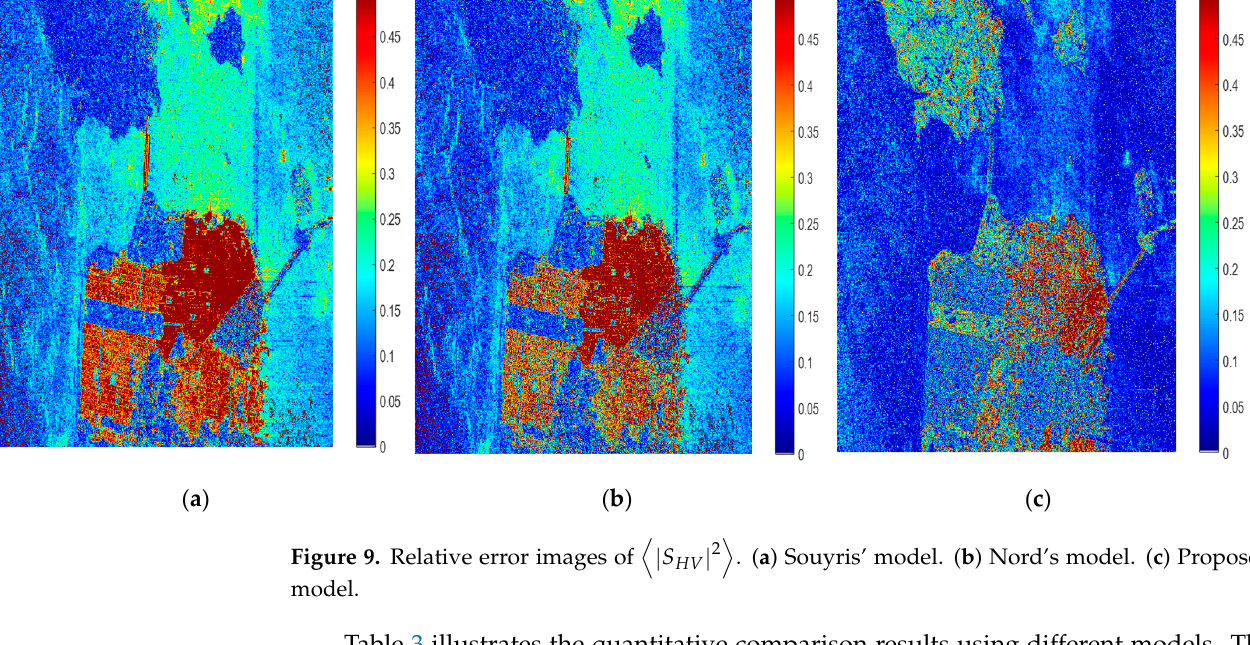
Table 3. Quantitative analysis of the parameters reconstructed using different models on ALOS-2